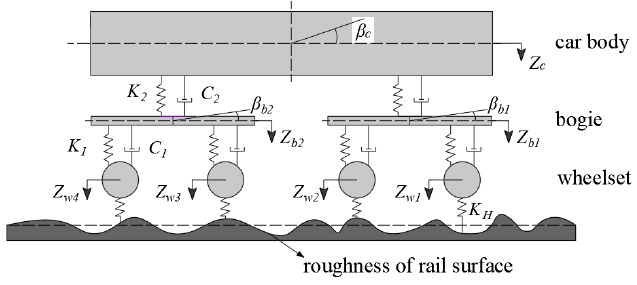
Figure 1. Simulation of the vehicle.